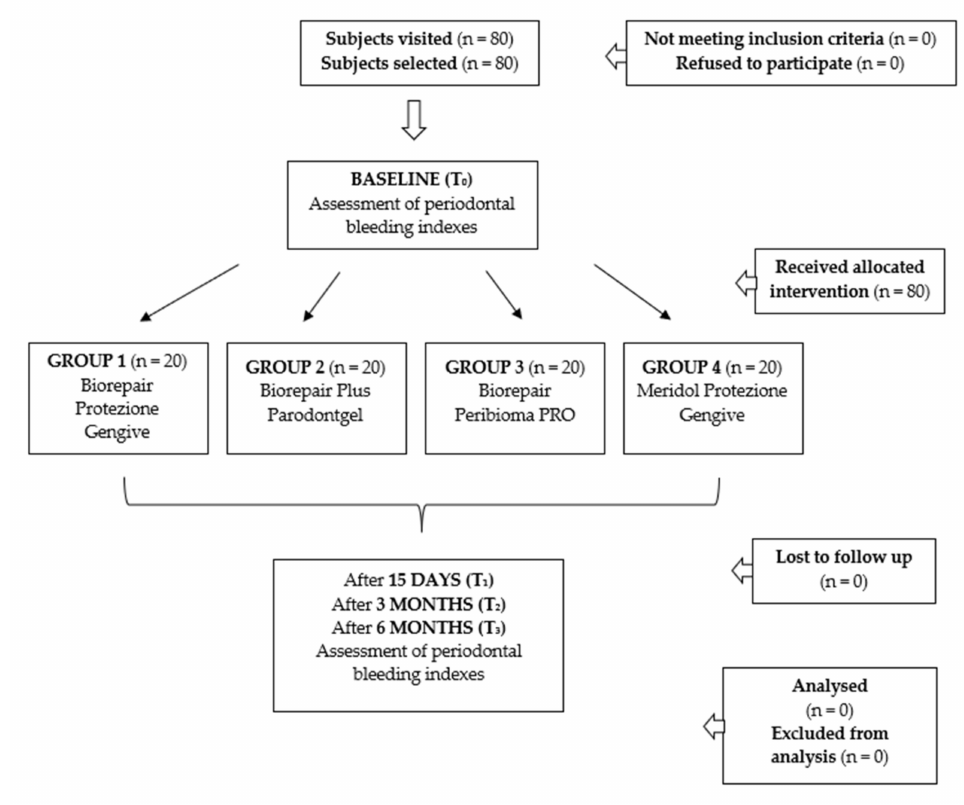
Figure 1. Flowchart of the